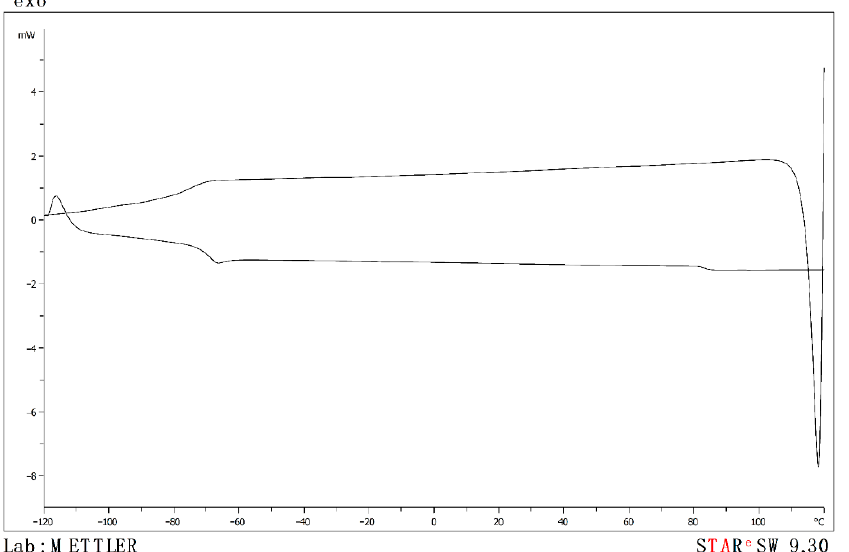
Figure 3. Thermogram cooling the sample from 393.15 K to 133.15 K and heating from 393.15 K to 133.15 K at a rate of 2 K·min − 1 for the equimolar binary mixture (1,1) PMpipTFO + (1,1) PMpipNTf 2 .